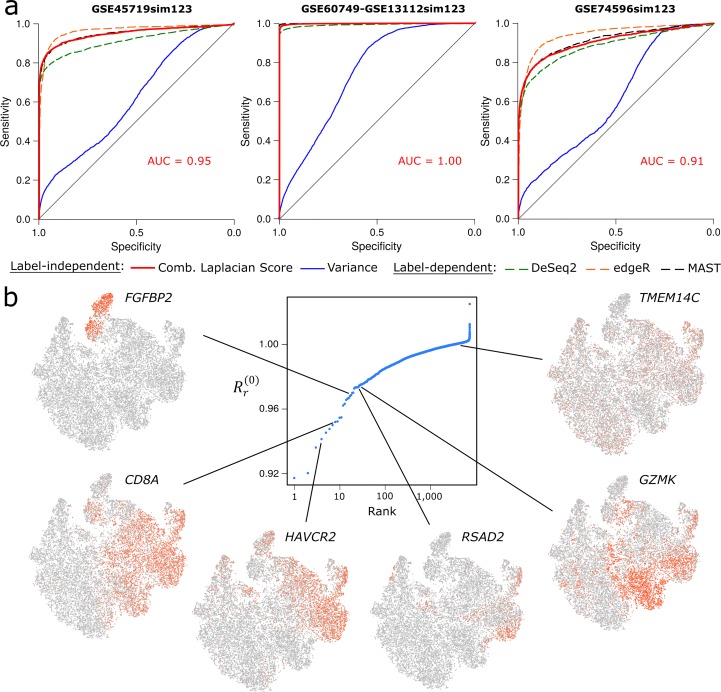
Differential expression analysis using the combinatorial Laplacian score.(a) ROC curves for three simulated scRNA-seq datasets with 10% of the genes being differentially expressed between two populations of cells. The 0-dimensional combinatorial Laplacian score, DeSeq2, edgeR, MAST, and variance were used to identify differentially expressed genes. Conventional methods (DeSeq2, edgeR, and MAST) in addition took as input a list of labels assigning each cell to the corresponding population. (b) Analysis of scRNA-seq data of 24,911 T-cells infiltrating lung tumors and adjacent tissues. Genes were ranked according to their 0-dimensional combinatorial Laplacian score. t-SNE plots color-coded for expression (grey to red) are shown for some of the top differentially expressed genes identified by this method. For reference, the expression of a gene with high combinatorial Laplacian score (TMEM14C) is also displayed. To facilitate interpretation, we use the same t-SNE embedding as in [23].